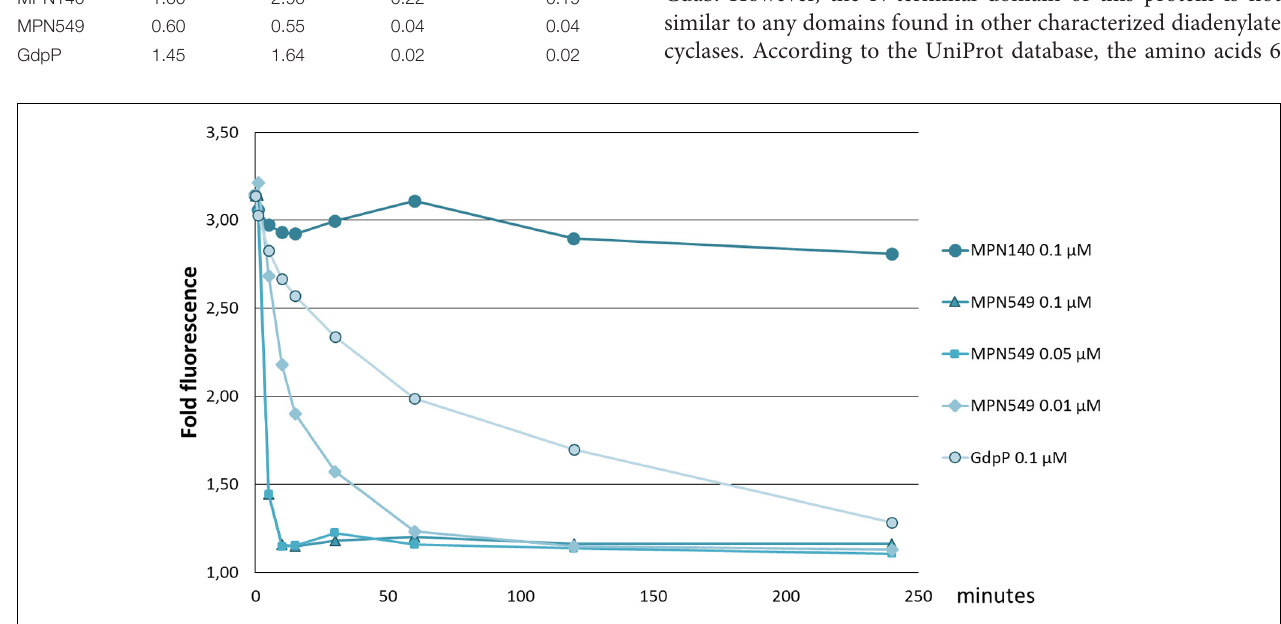
FIGURE 2 | Specific activity of phosphodiesterases toward c-di-AMP. Phosphodiesterases (MPN140, MPN549, GdpP: 100 nM, in addition 50 and 10 nM for MPN549) were added to 100 µ M c-di-AMP in 100 mM Tris-HCl pH8.3, 10 mM NaCl, 0.1 mM MnCl 2 at 37 ◦ C. Reactions were stopped at 0, 5, 10, 15, 30, 60, 120, and 240 min. Upon addition of KBr and coralyne and excitation at 420 nm, fluorescence at 475 nm was measured. The ratio of c-di-AMP-mediated emission vs. a standard without c-di-AMP is shown. Results from a typical experiment are shown. The replicates showed similar results.